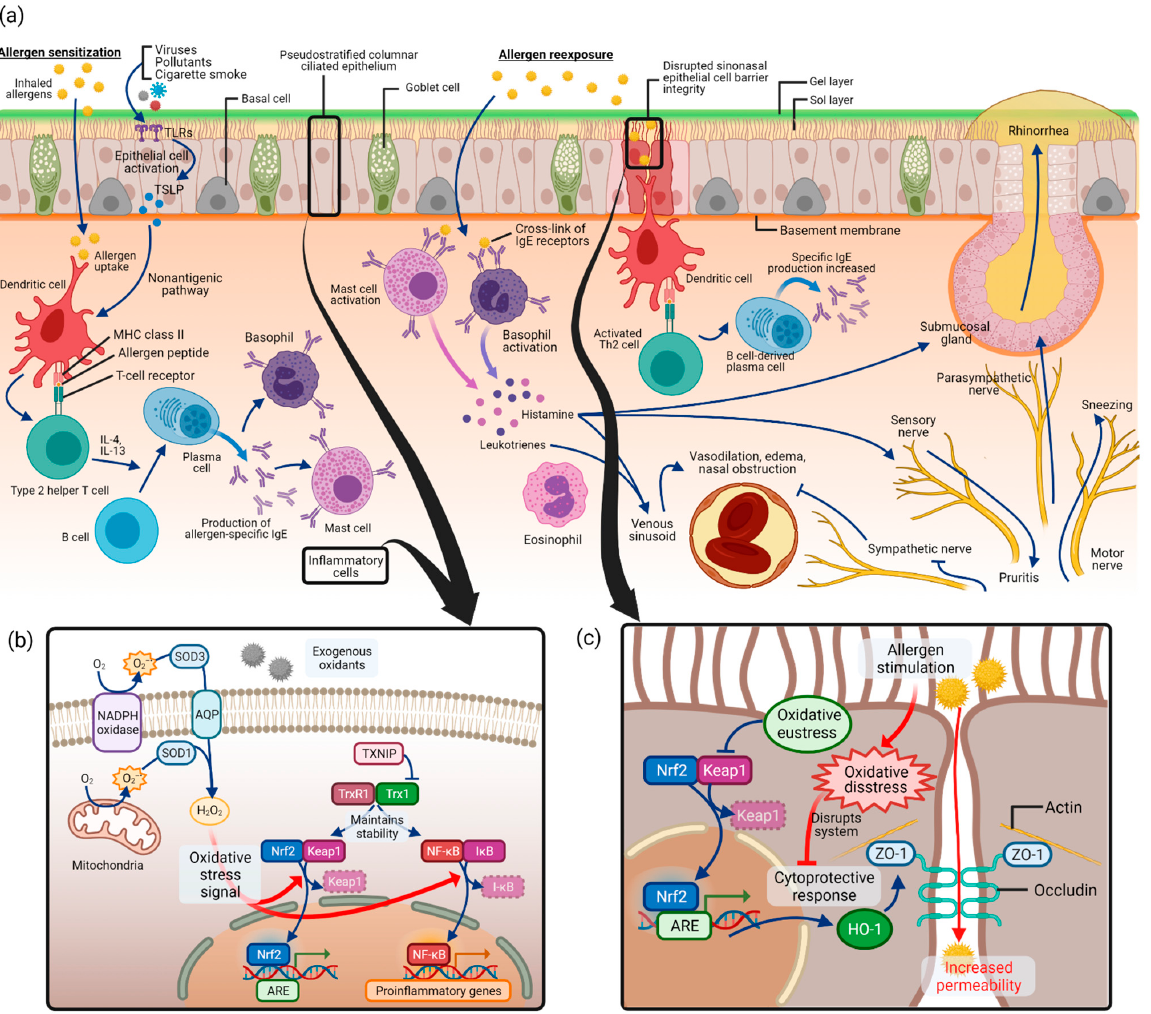
Figure 3. Allergic rhinitis and oxidative stress pathways: ( a ) pathogenesis of allergic rhinitis as in allergic sensitization followed by allergen reexposure; ( b ) regulation of signaling pathways by Nrf2 and NF ‐κ B in oxidative stress of allergic rhinitis; ( c ) disrupted sinonasal epithelial cell barrier integrity in allergic rhinitis and associated oxidative stress pathway. Abbreviations: NADPH, nicotine adenine dinucleotide phosphate; SOD, superoxide dismutase; AQP, aquaporin; H2O2, hydrogen peroxide; TXNIP, thioredoxin ‐ interacting protein; TrxR1, thioredoxin reductase 1; Trx1, thioredoxin 1; Nrf2, nuclear factor erythroid 2 ‐ related factor 2; Keap1, Kelch ‐ like ECH ‐ associated protein 1; NF ‐κ B, nuclear factor kappa ‐ light ‐ chain ‐ enhancer of activated B cells; I κ B, inhibitor of NF ‐κ B; ARE, antioxidant response element; HO ‐ 1, heme oxygenase ‐ 1; ZO ‐ 1, zonula occludens ‐ 1.